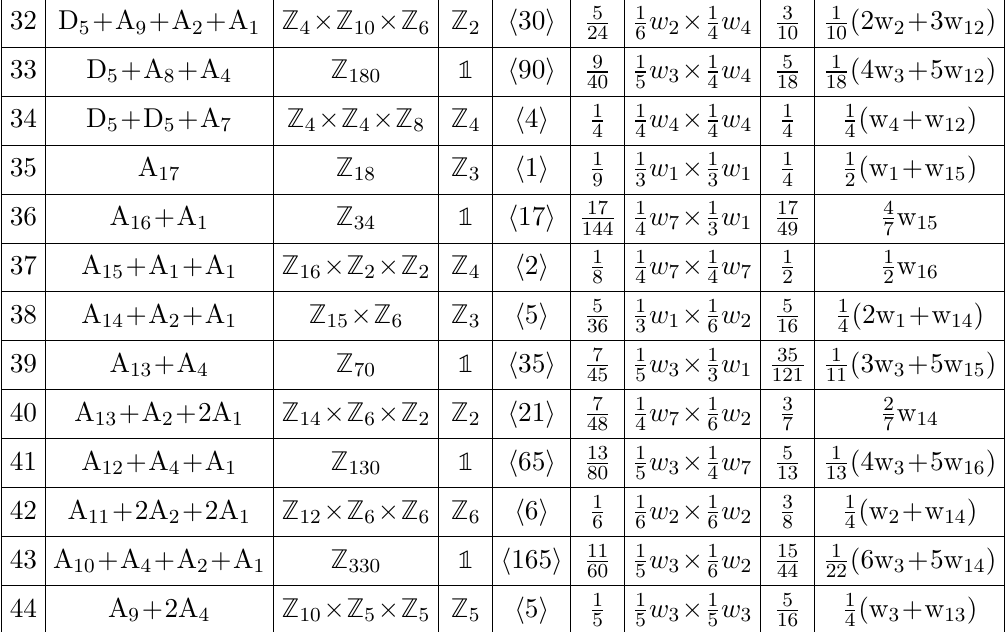
Table 11. Data for allowed groups of maximal rank, d = 1. ( R E ;A E ) and ( R O ;A O ) are the radius and Wilson line in the E 8 (cid:2) E 0 and Spin(32) = Z 2 heterotic 8